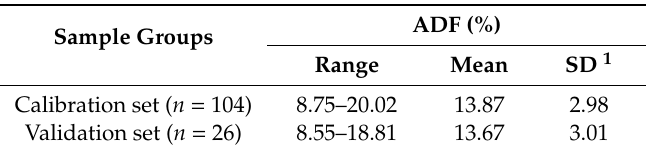
Table 2. ADF content in the turnip greens and turnip tops samples from the calibration and validation set of Brassica rapa analysed following the reference method.